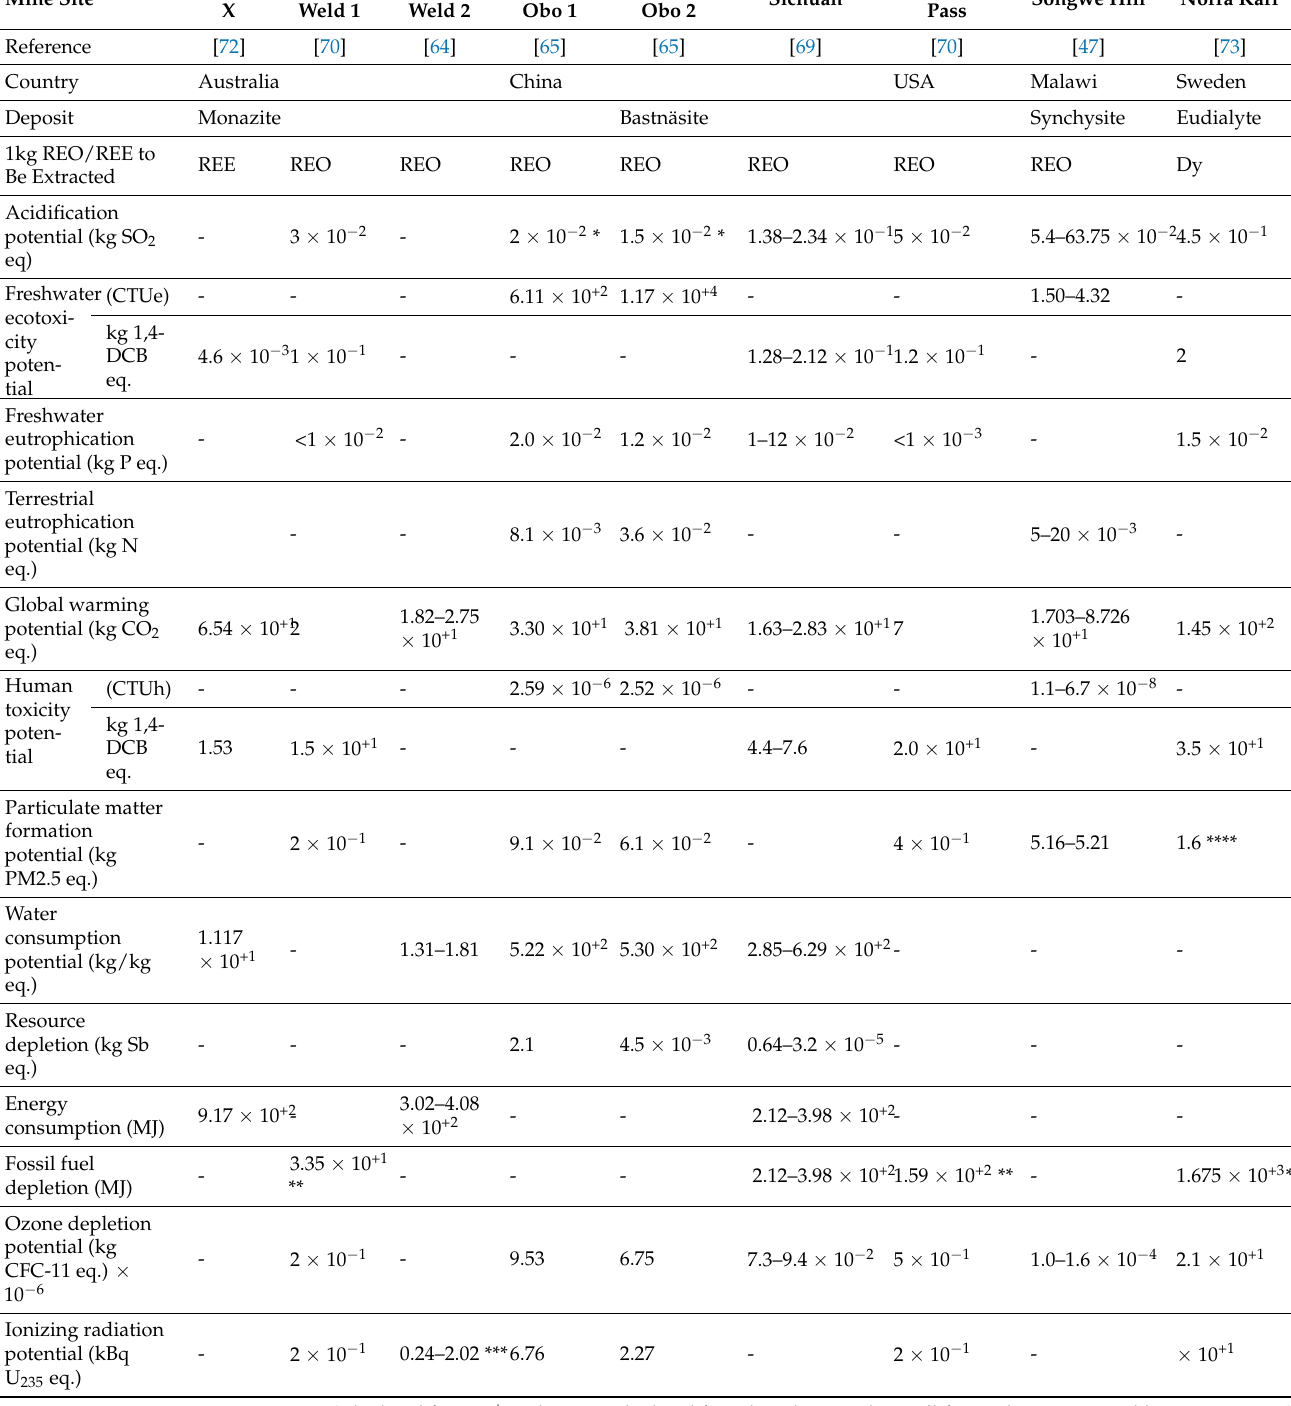
Table A2. LCA of REE primary production from bastnäsite, monazite, synchysite, and eudialyte